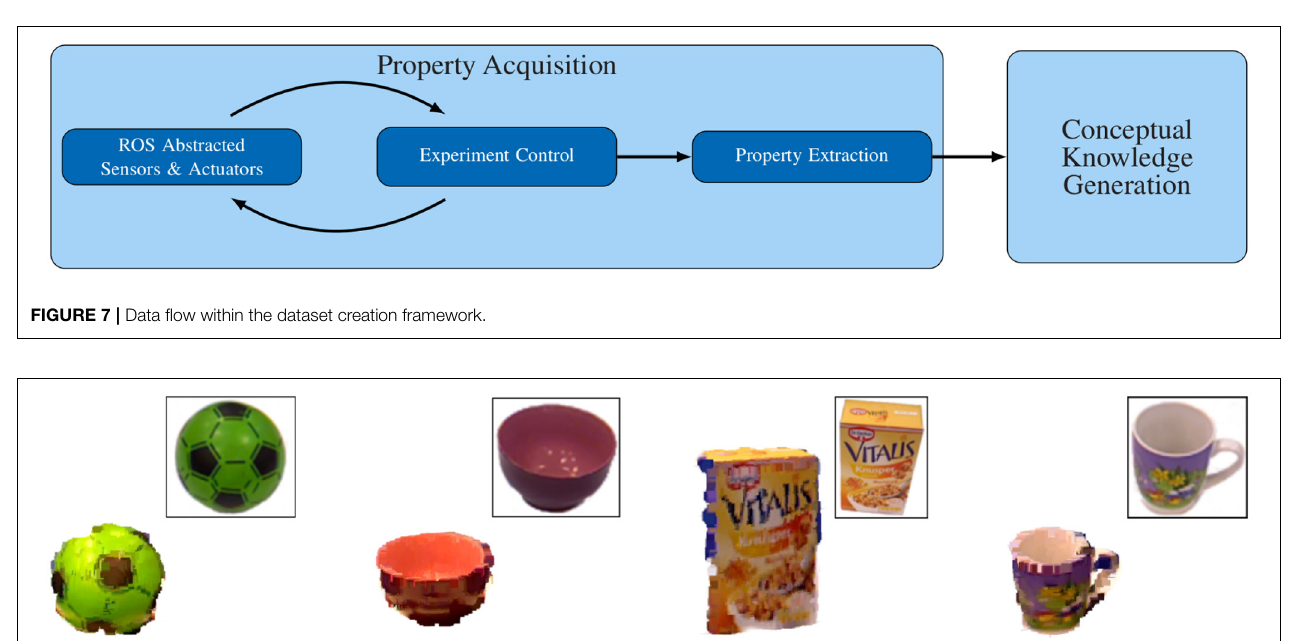
FIGURE 8 | RoCS dataset samples: Point cloud and RGB images of a ball , bowl , paper box , and cup (for visualization purposes, images are scaled and 3D points are